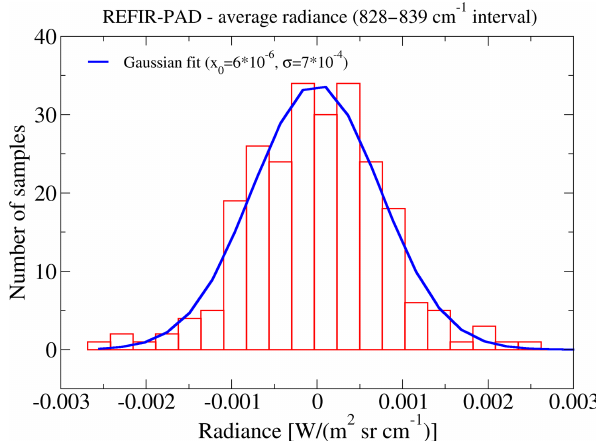
Figure 7. Statistical analysis of the average radiometric signal in a high-transparency window (828–839cm − 1 ) for RHUBC-II mea- surements. Radiometric bias is close to zero, while the half width of the Gaussian distribution is 0.7mW ( m 2 srcm − 1 ) − 1 .